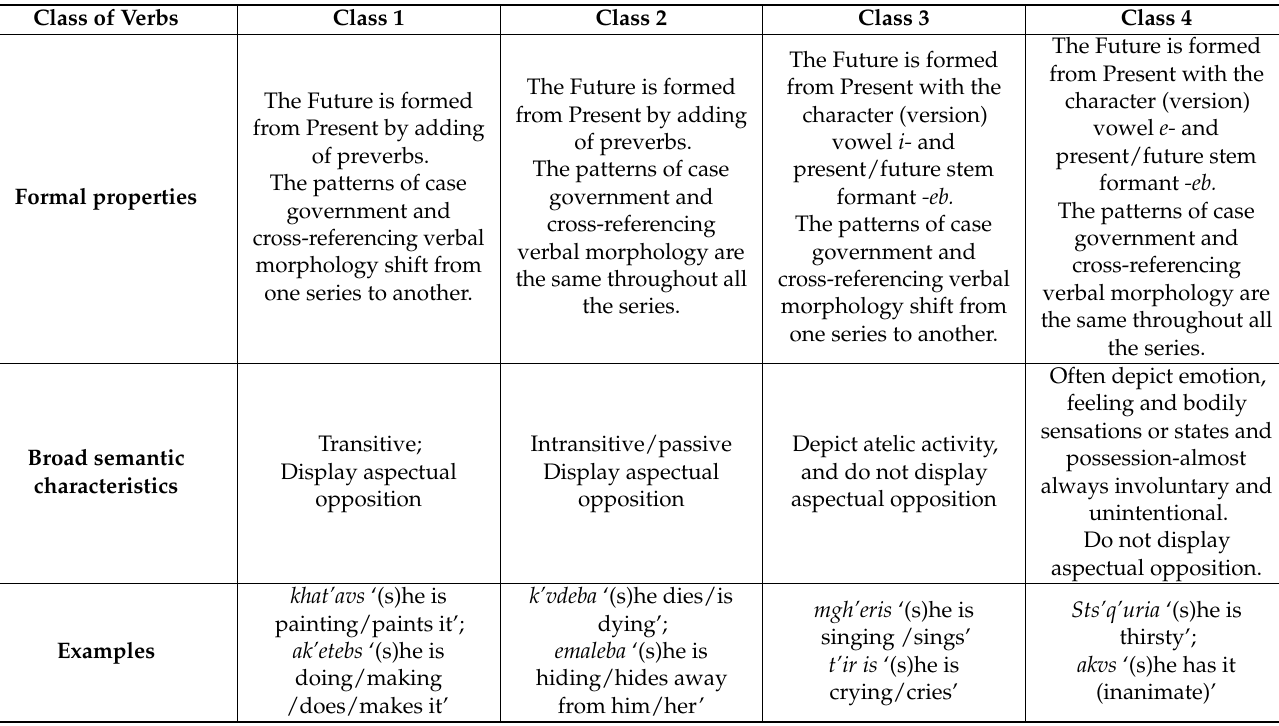
Table 3. Verb classes in Georgian.